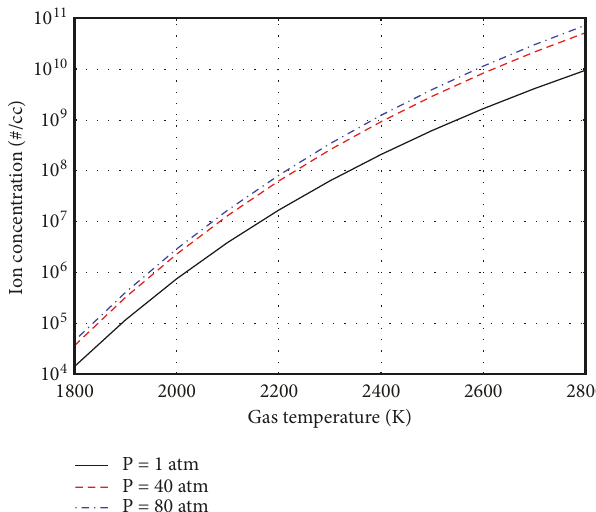
Figure 2: Effect of electron temperature (T (ions/cc) of H 3 O + and NO + under laboratory flame conditions (P = 1 atm) for a stoichiometric propane-air mixture.